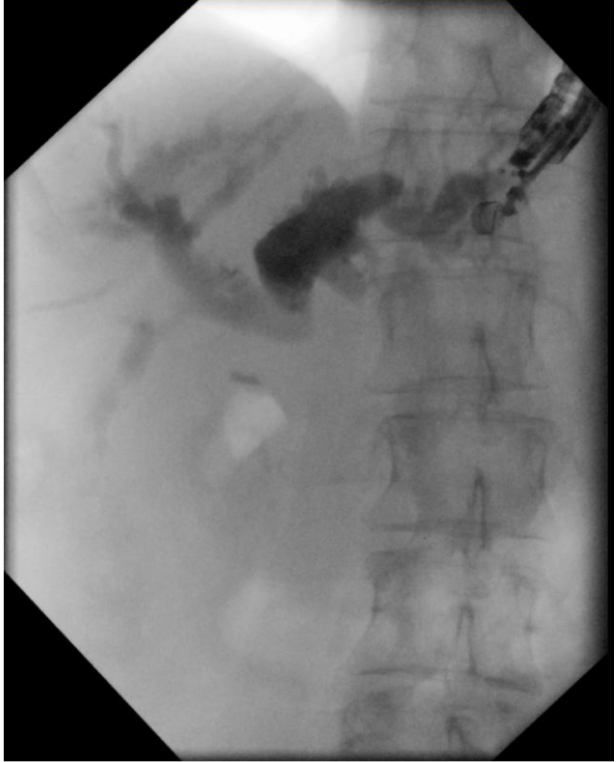
Figure 3. EUS-Biliary Drainage (EUS-BD): Fluoroscopic image of an EUS-obtained